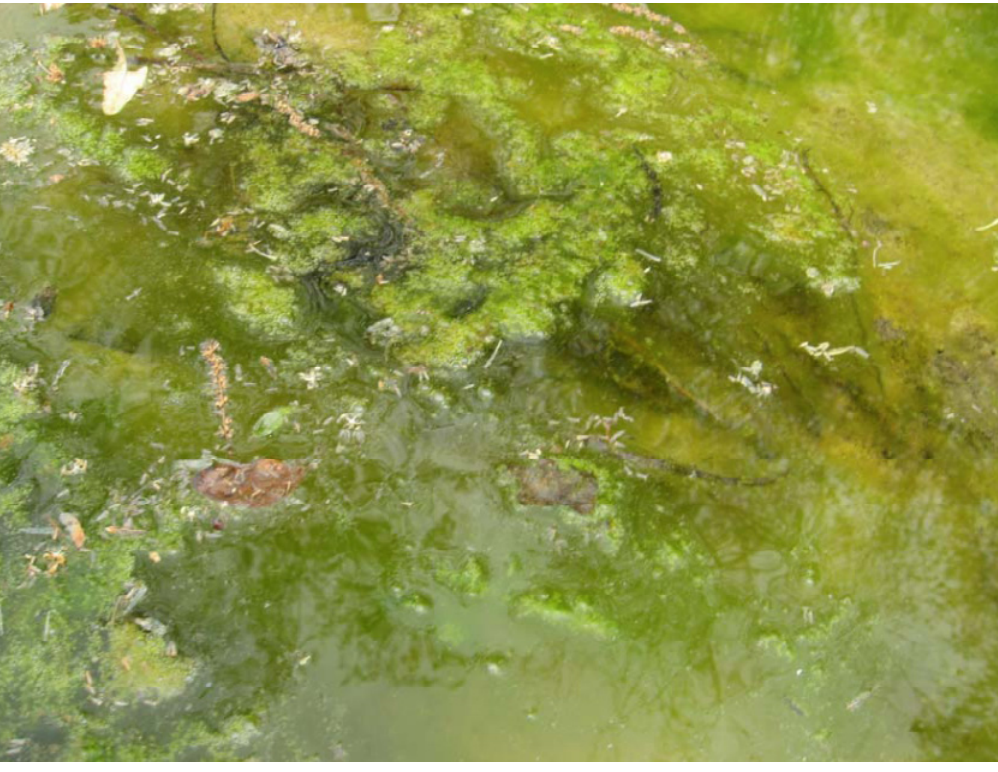
Figure 6. Photograph of Site 11 (Beaver Creek on Honeysuckle Rd.) during September